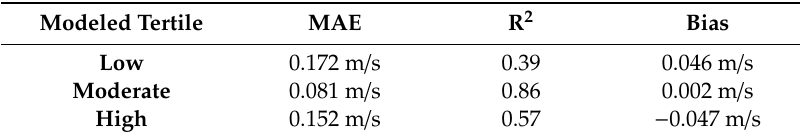
Table 3. Model Cross-Validation